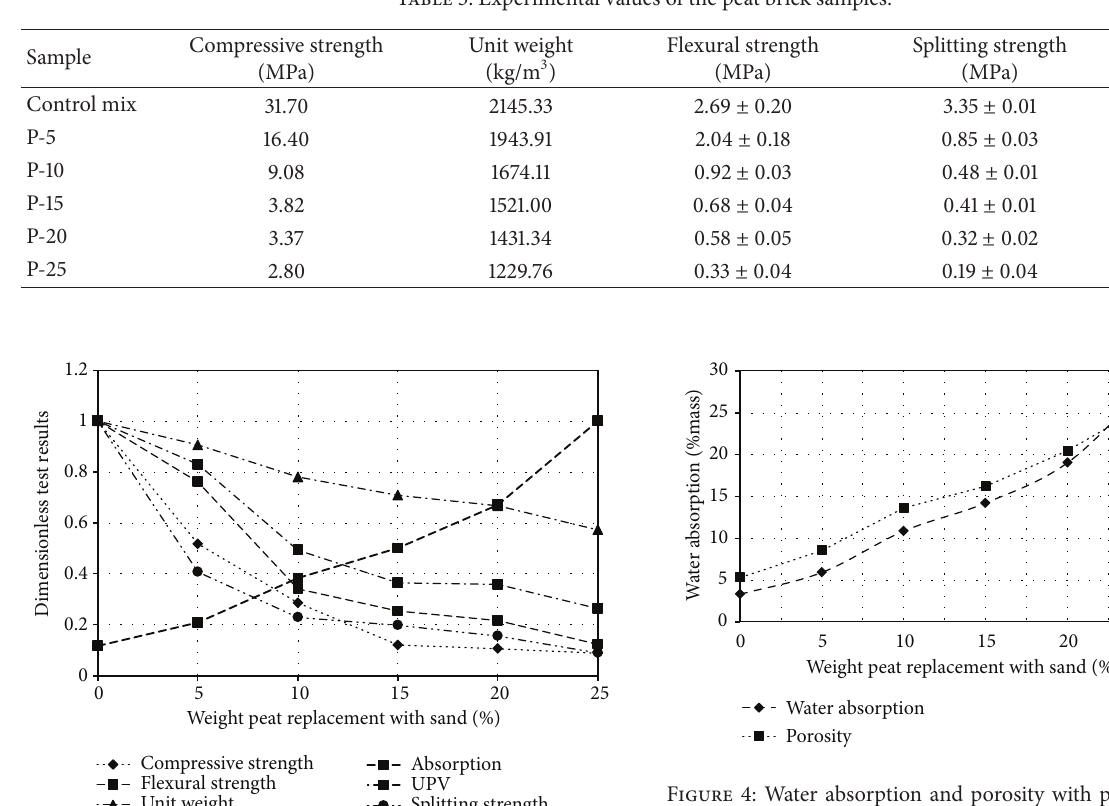
Figure 3 indicates that unit weight values of the sample are inversely proportional to the percentage of peat. The